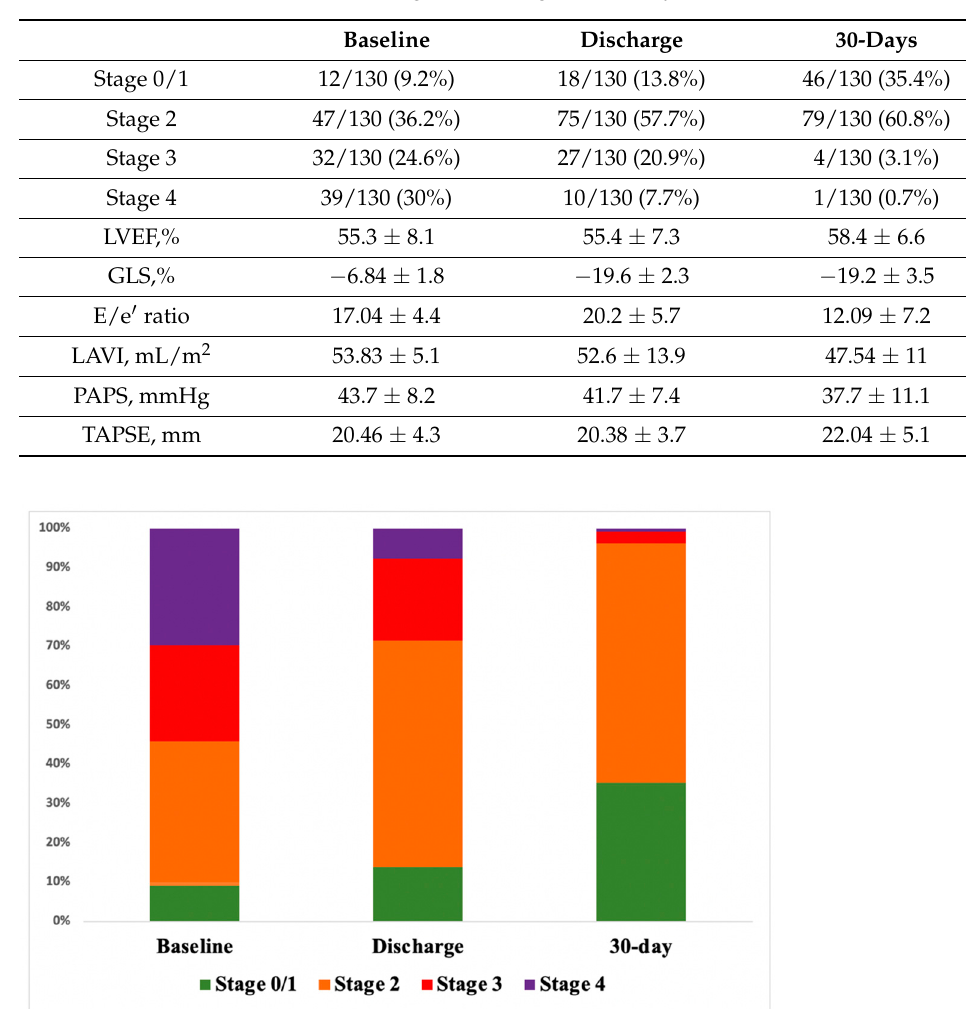
Figure 2. Re-assessment of cardiac damage at discharge and at 30-days after TAVI.